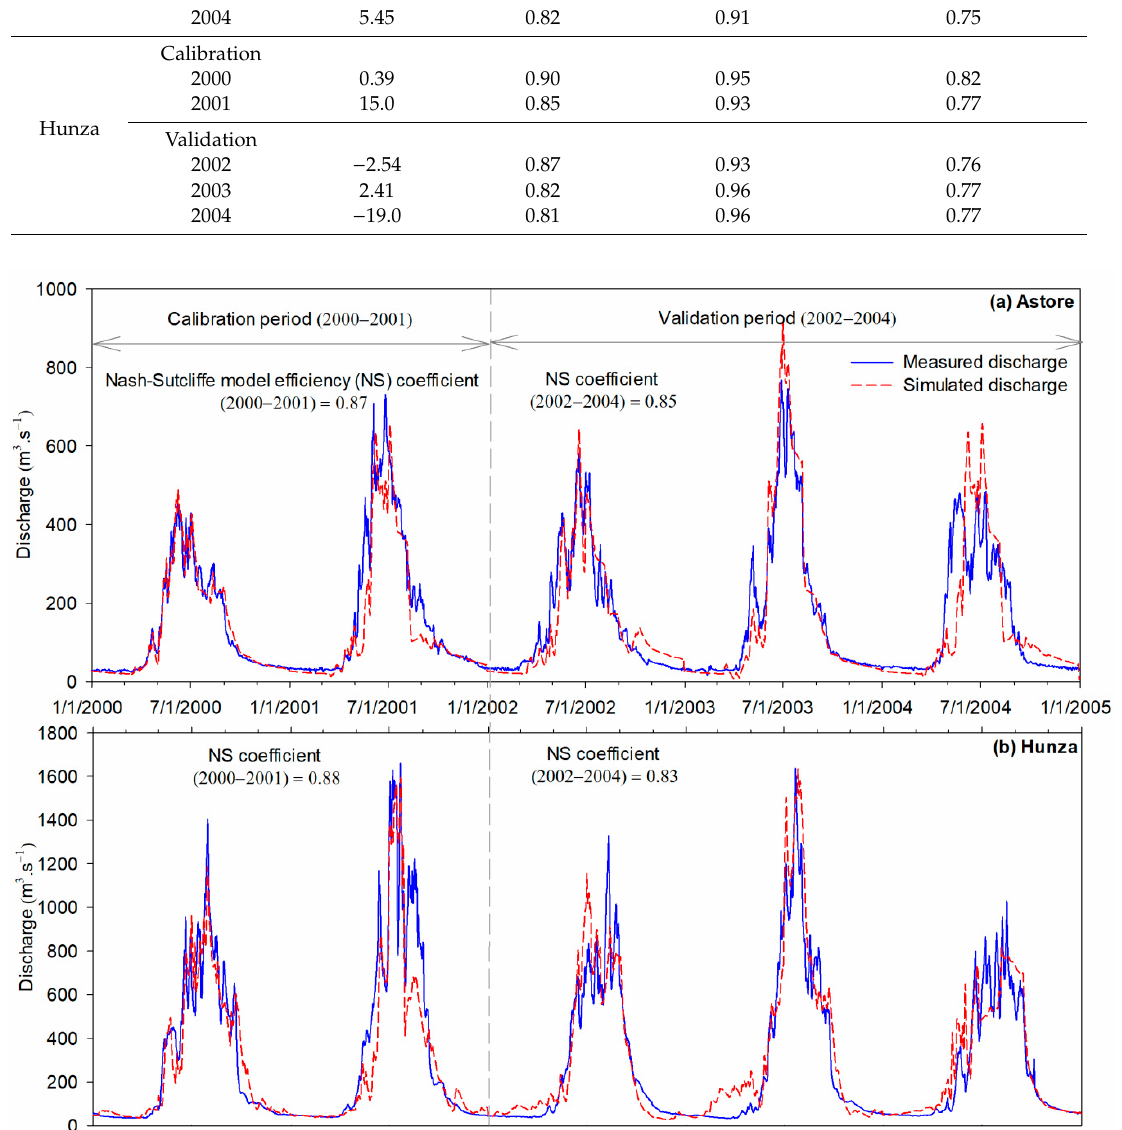
Figure 6. Evaluation of zone-wise (ZW) SRM application over 2000–2004 period for ( a ) Astore and ( b ) Hunza basins.